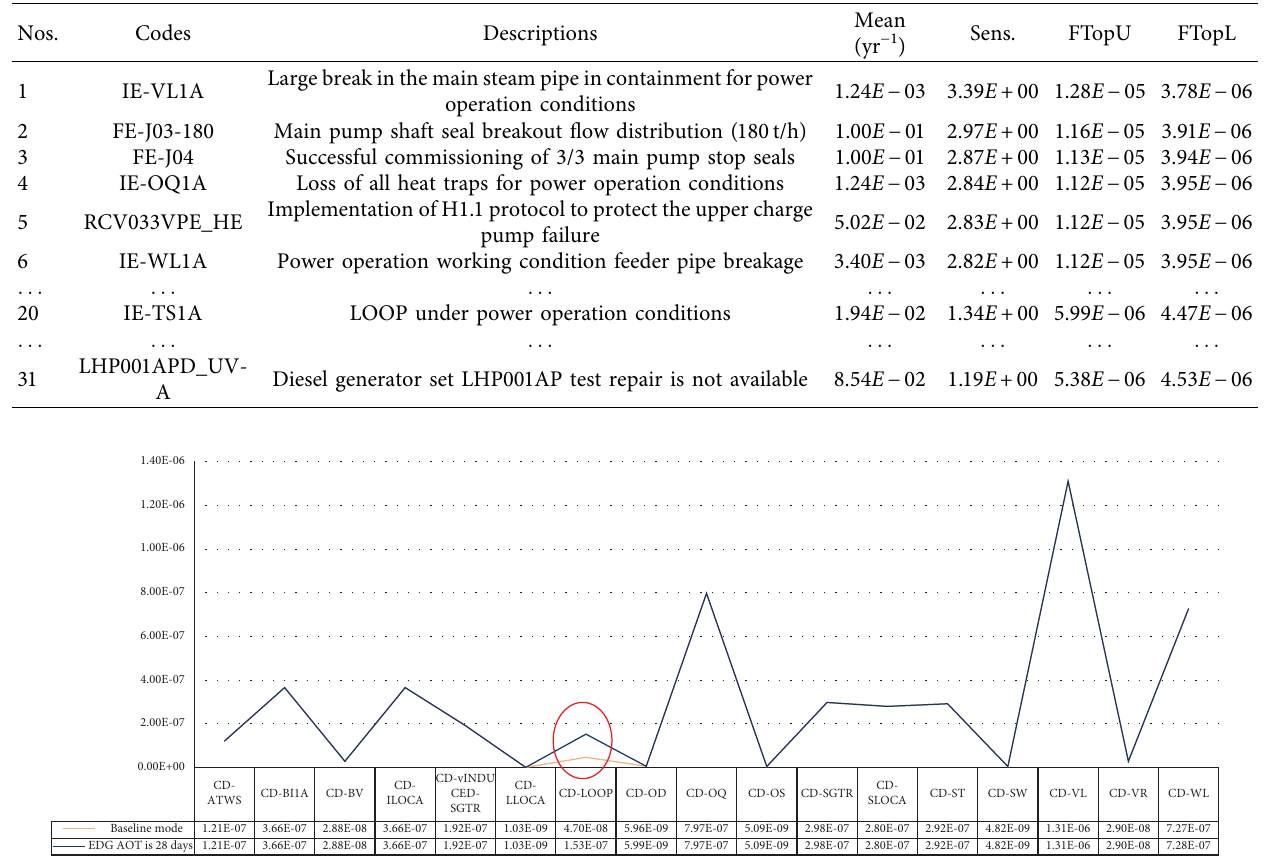
Table 4: Sensitivity analysis when EDG AOT is 28 days.